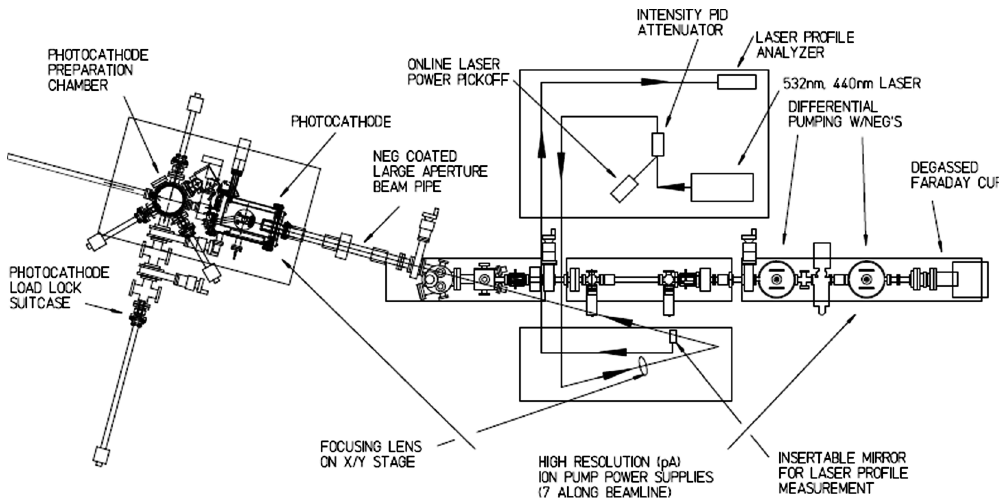
FIG. 5. Schematic of the photogun and beam line at JLab’s Injector Test Stand